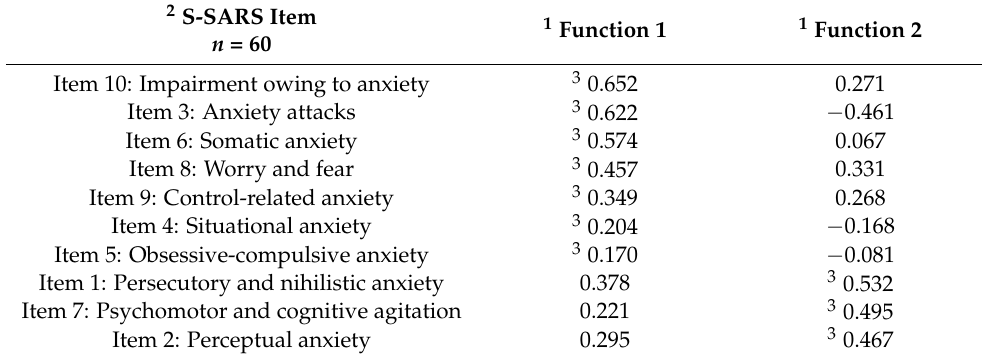
Figure 1. Diagnostic group centroids of the canonical discriminant functions. Table 5. Structure matrix of the S-SARS items contributing to the standardised canonical functions.